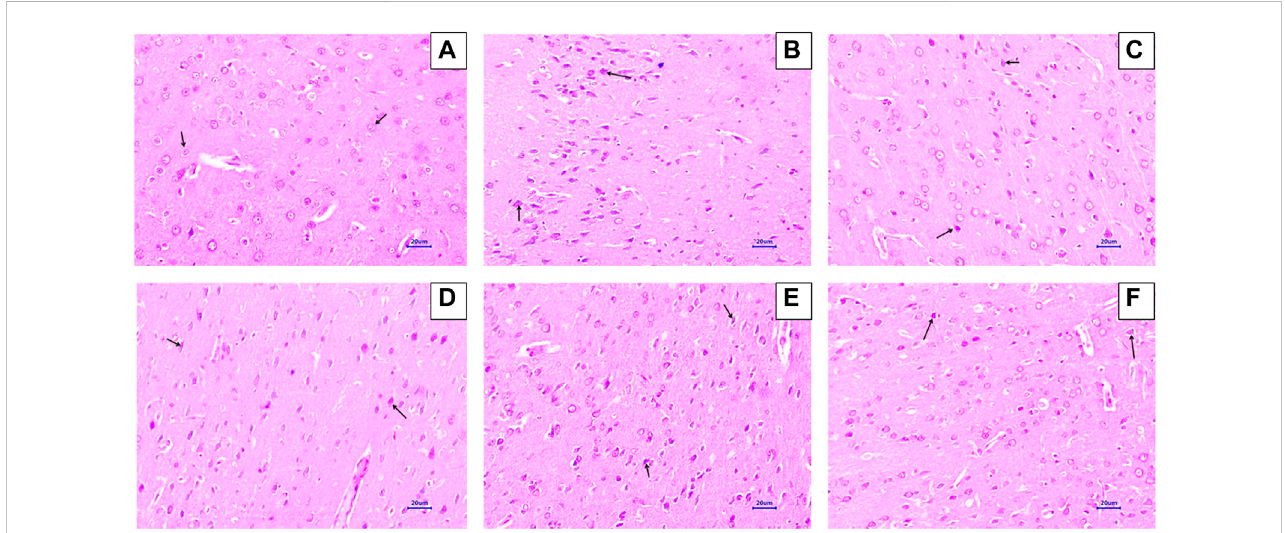
FIGURE 4 Effects of baicalein and baicalein with memantine on H&E-stained cortex tissue (400X), (A) Normal control: showing normal histology and normal neuronal cells in the parietal cortex (small arrow) (B) Disease control: showing neuronal degeneration with pyknotic nuclei in the cortex (small arrow) (C) Memantine (20 mg/kg): showing normal histology, normal neuronal cells in the parietal cortex (small arrow), (D) Baicalein (10 mg/kg): showing neuronal degeneration with pyknotic nuclei in the cortex (small arrow), (E) Memantine + baicalein (20+5 mg/kg): showing neuronal degeneration with pyknotic